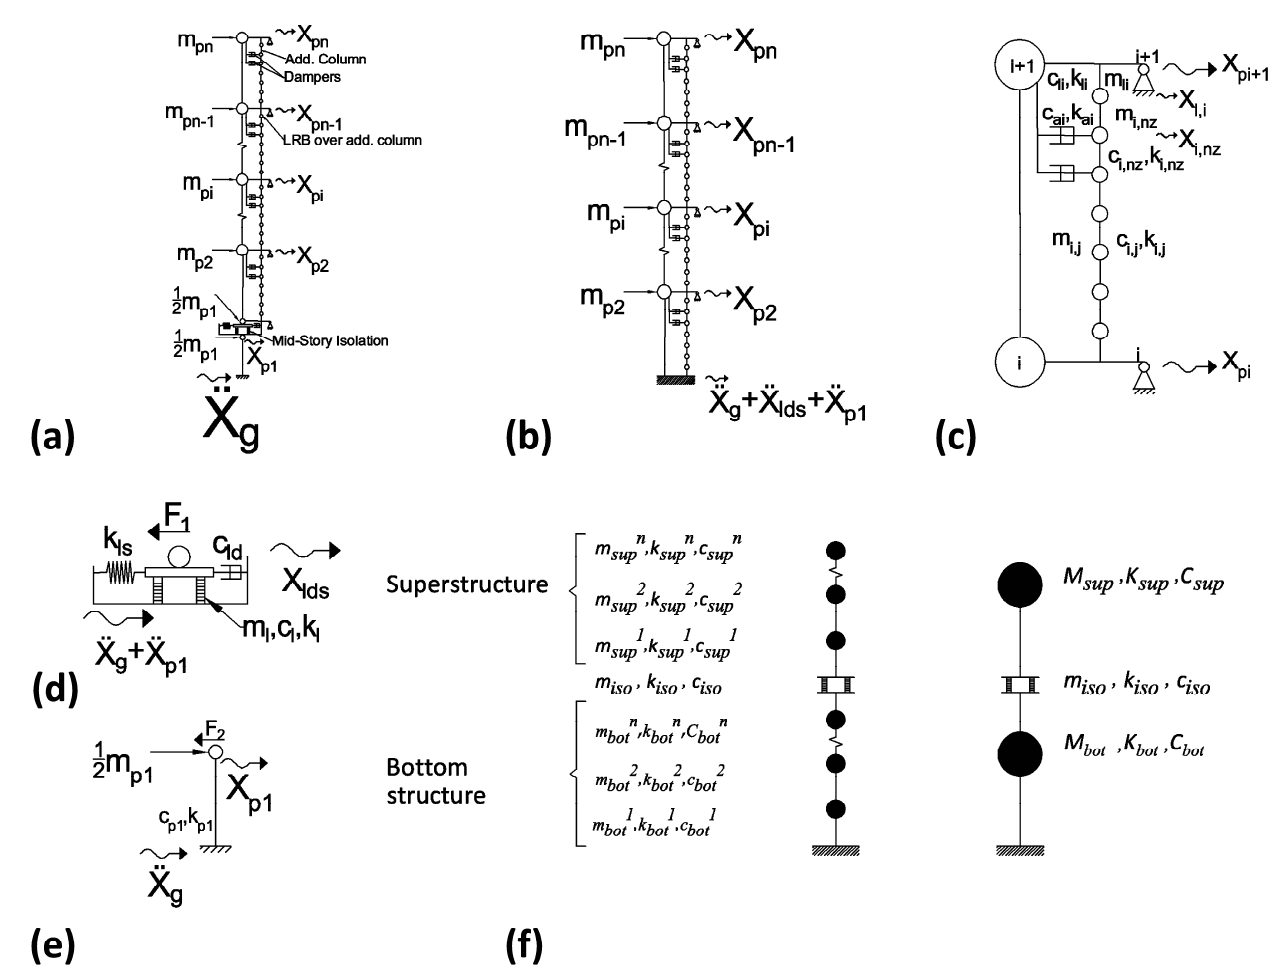
Figure 3. Computing model of newly proposed MSCSS [21]: ( a ) whole system, ( b ) superstructure, ( c ) i th Substructure, ( d ) mid-story isolator, ( e ) bottom structure, and ( f ) three-lumped-mass structural model. (Adapted with permission from [21])